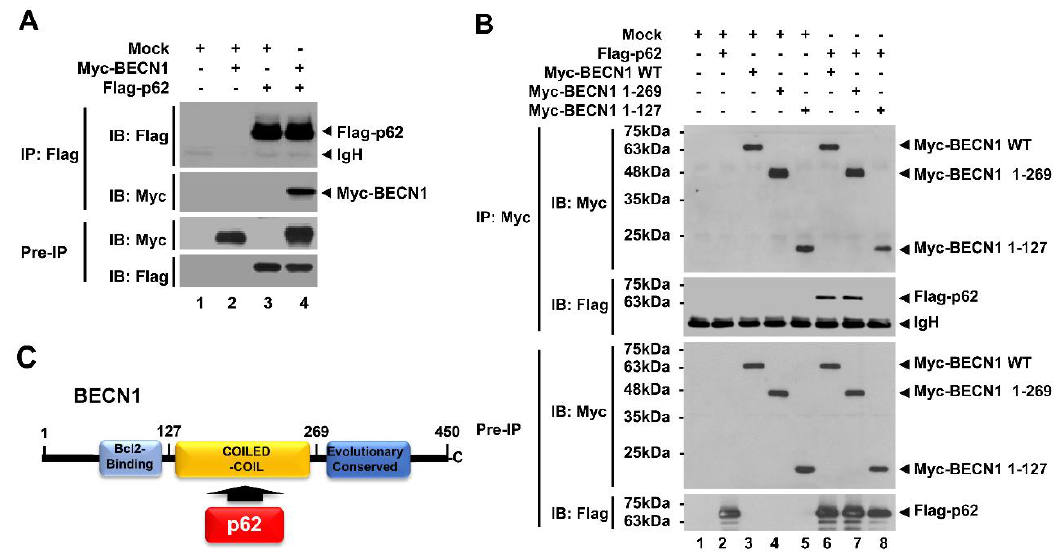
Figure 1. p62 interacts with BECN1 proteins. ( A ) HEK293T cells were transfected with mock control vector, Flag-tagged p62, or Myc-tagged BECN1, as indicated. Transfected cells were harvested, and cell lysates were immunoprecipitated with anti-Flag antibody and probed with anti-Myc or anti-Flag antibody. ( B ) HEK293T cells were transfected with mock vector, Flag-tagged p62, or Myc-tagged BECN1 WT and Myc-tagged BECN1 truncated mutants. Transfected cells were harvested, and cell lysates were immunoprecipitated with anti-Myc antibody. Immunoprecipitated complexes were separated by SDS-PAGE, and probed with anti-Myc or anti-Flag antibody. ( C ) A schematic view of the molecular interaction between BECN1 and p62.